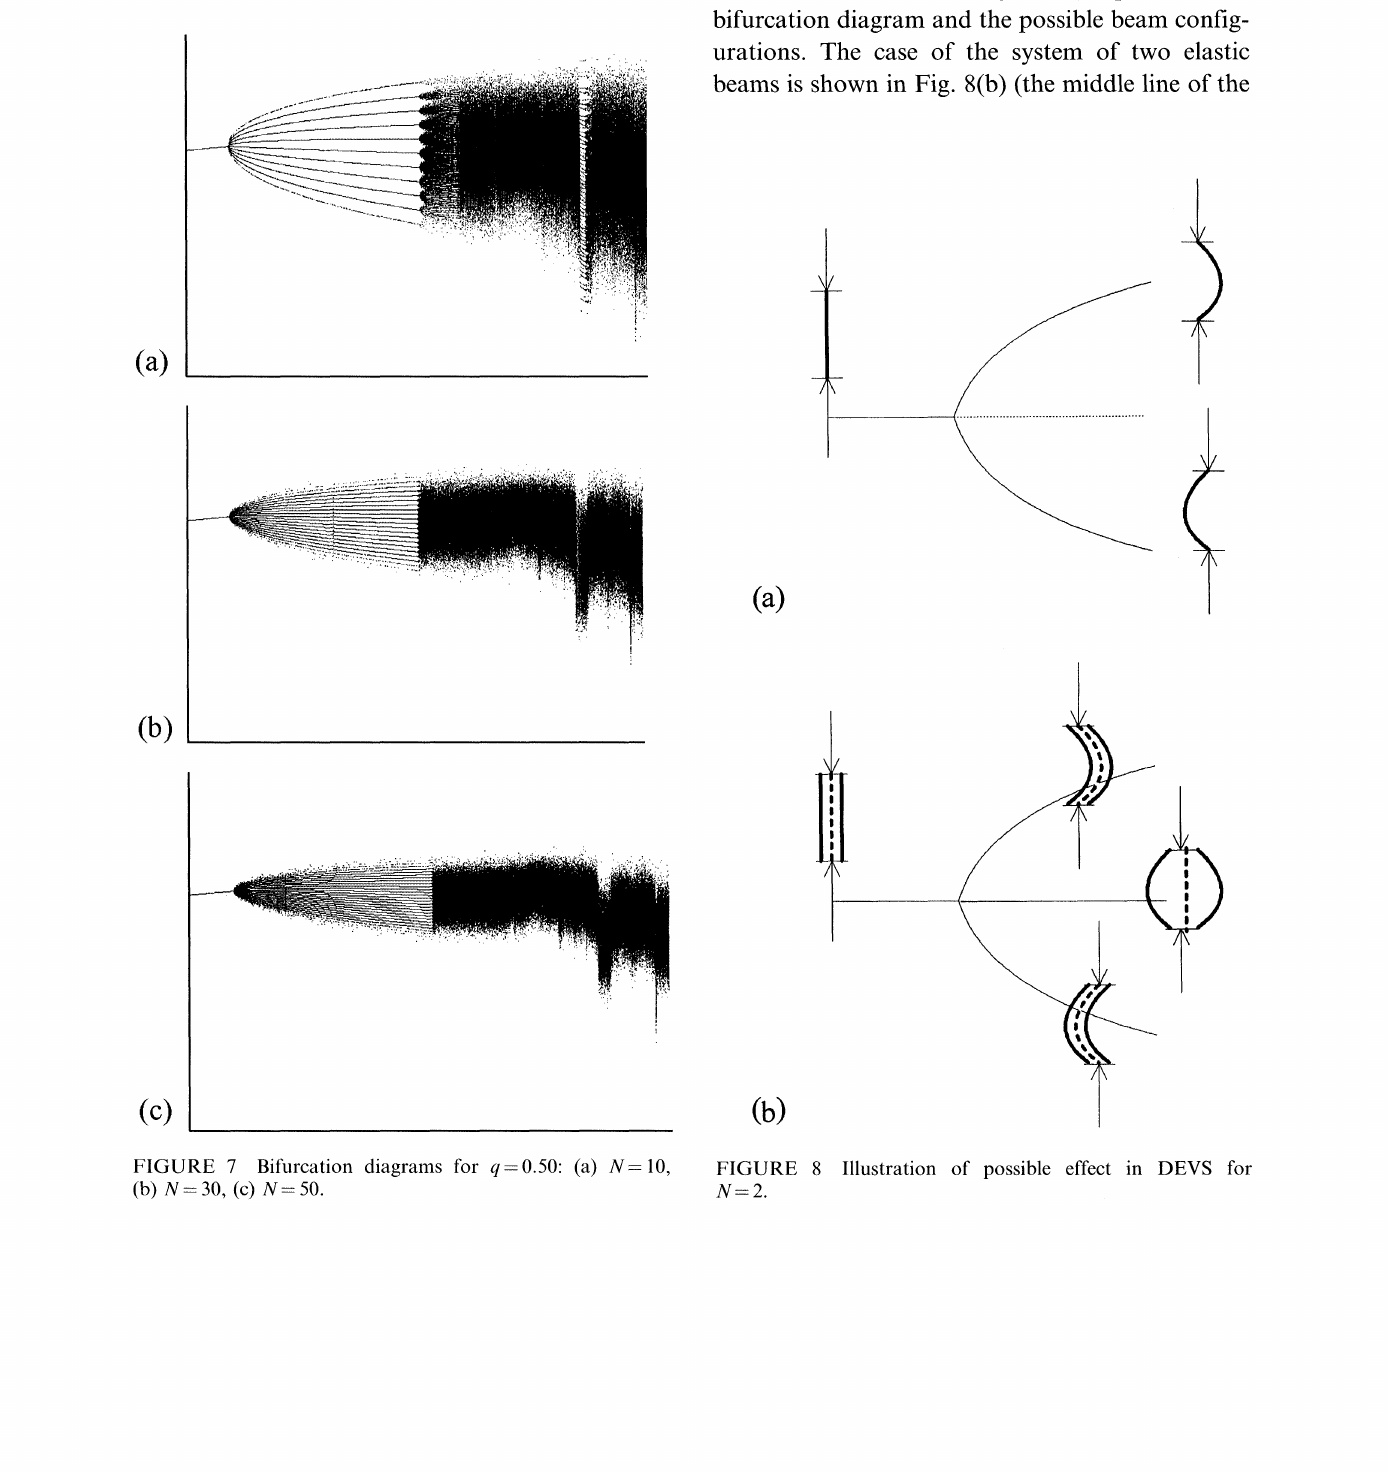
FIGURE 7 Bifurcation diagrams for q=0.50: (a) N--10, (b) U--30, (c) U--50.